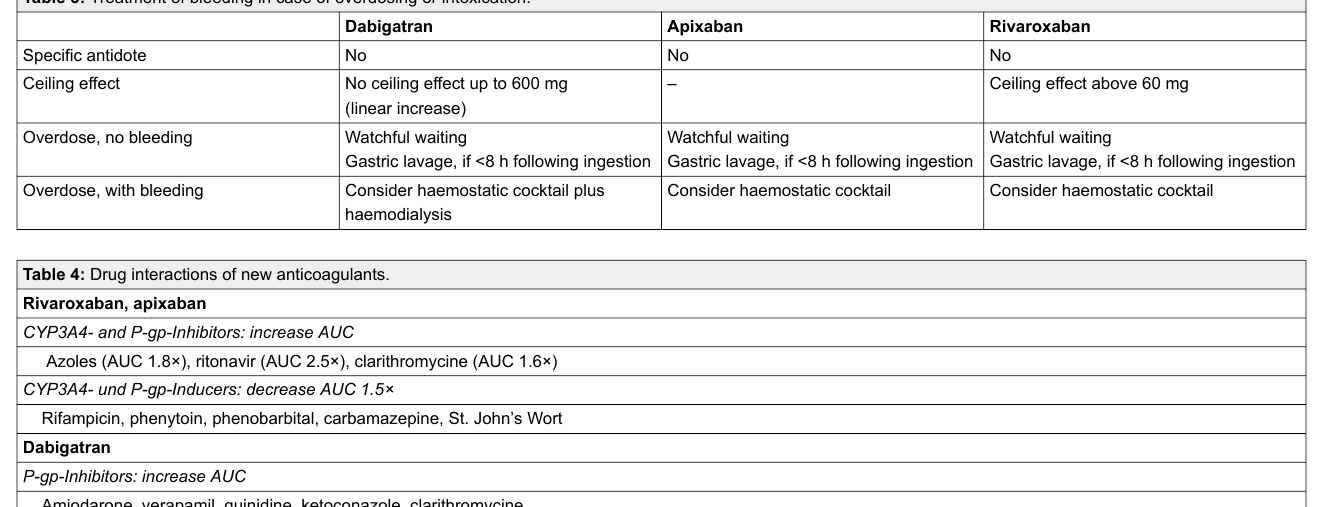
Table 3: Treatment of bleeding in case of overdosing or intoxication.